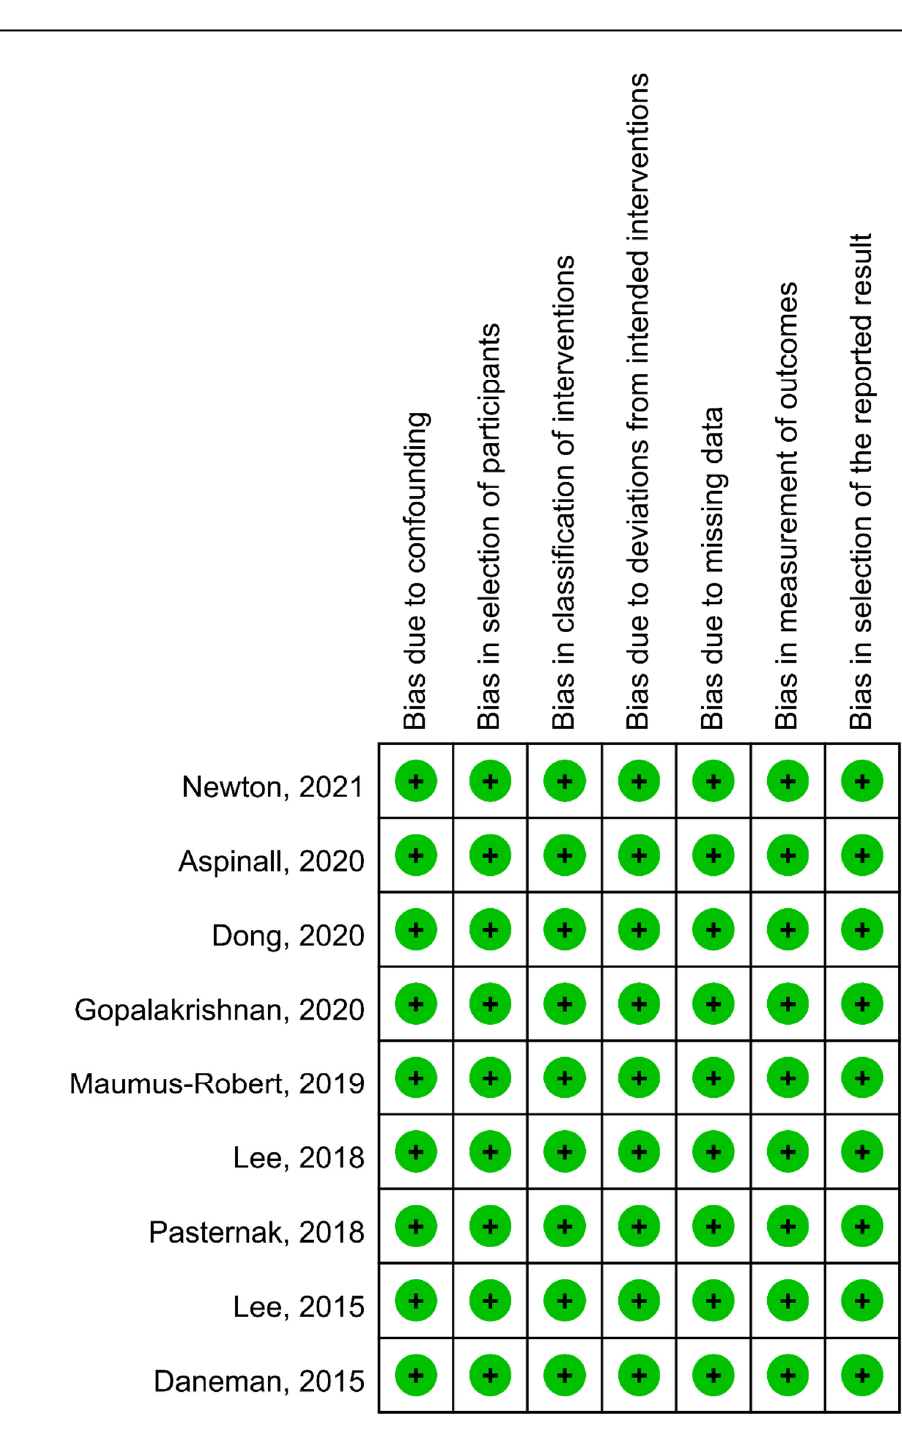
Figure 2. Summary of risk of bias.